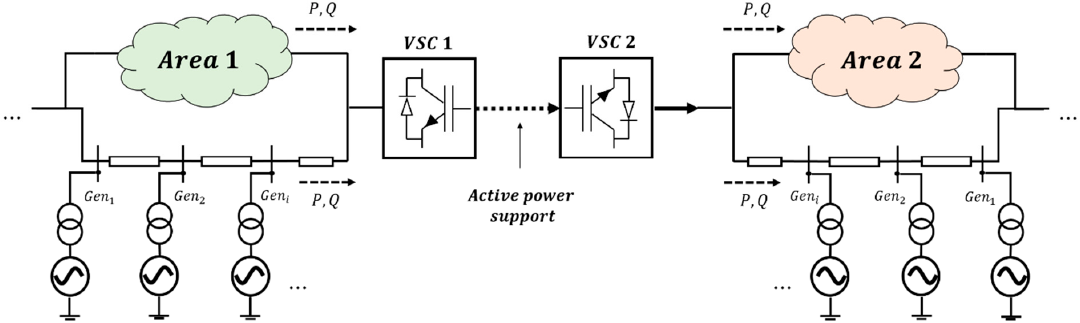
Figure 1. Two interconnected grids with a voltage-source converter (VSC)-based high-voltage DC